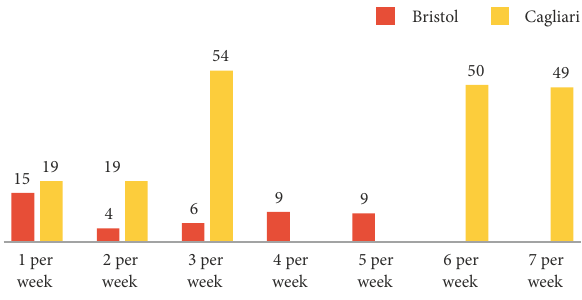
Figure 9. Number of boxes delivered on average per individual